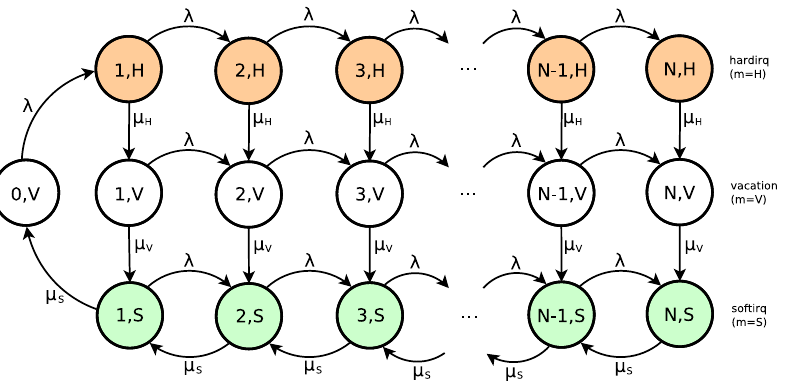
Figure 4. State-transition diagram of model